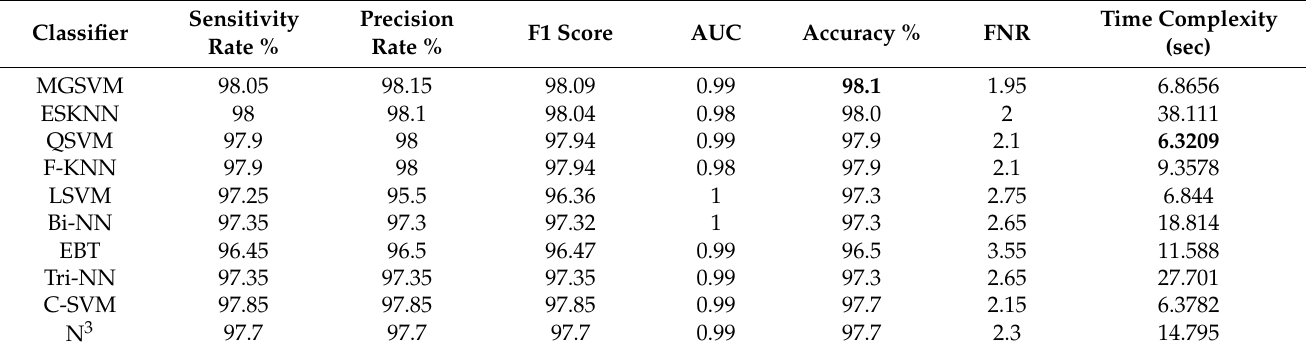
Table 7. Classification results of INbreast dataset using proposed enhanced images based on fine- tuned deep model